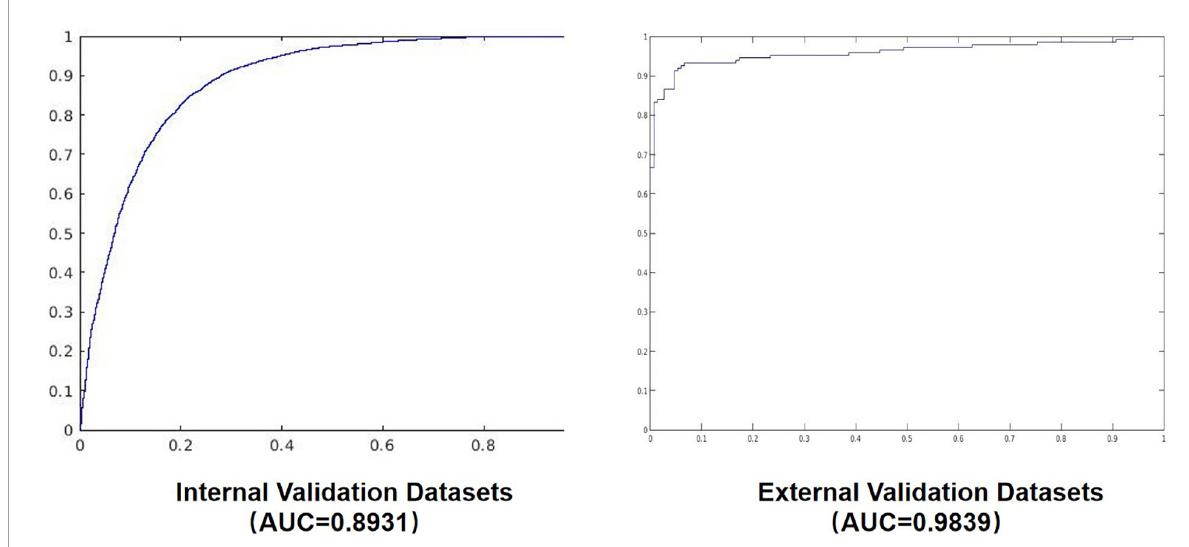
FIGURE5 The AUC diagram of the internal and external validation sets.